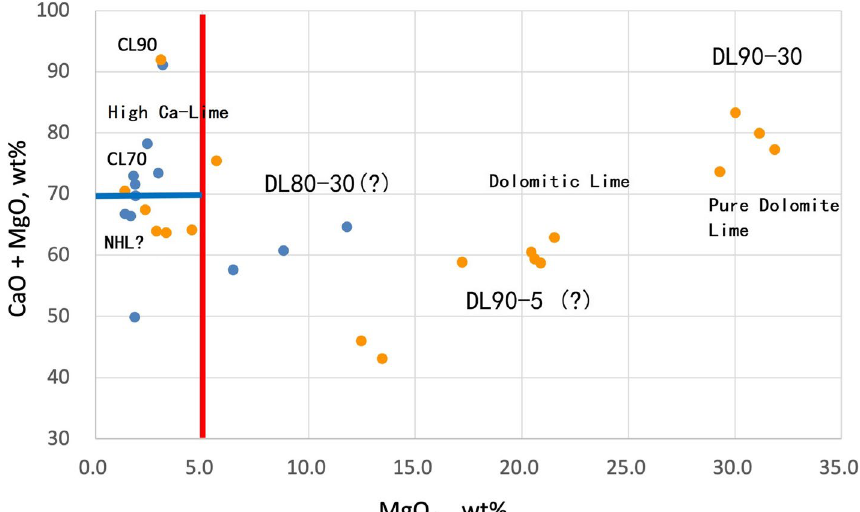
Fig. 16 Main chemical components of lime binders from the Ming Great Wall and estimated types of lime binders (yellow points are samples collected from the Great Wall built by the Ji Town administration, northern provinces, s. Figure 1, blue points are samples from other locations of Ming Great Wall documented in Table 1) (Source: